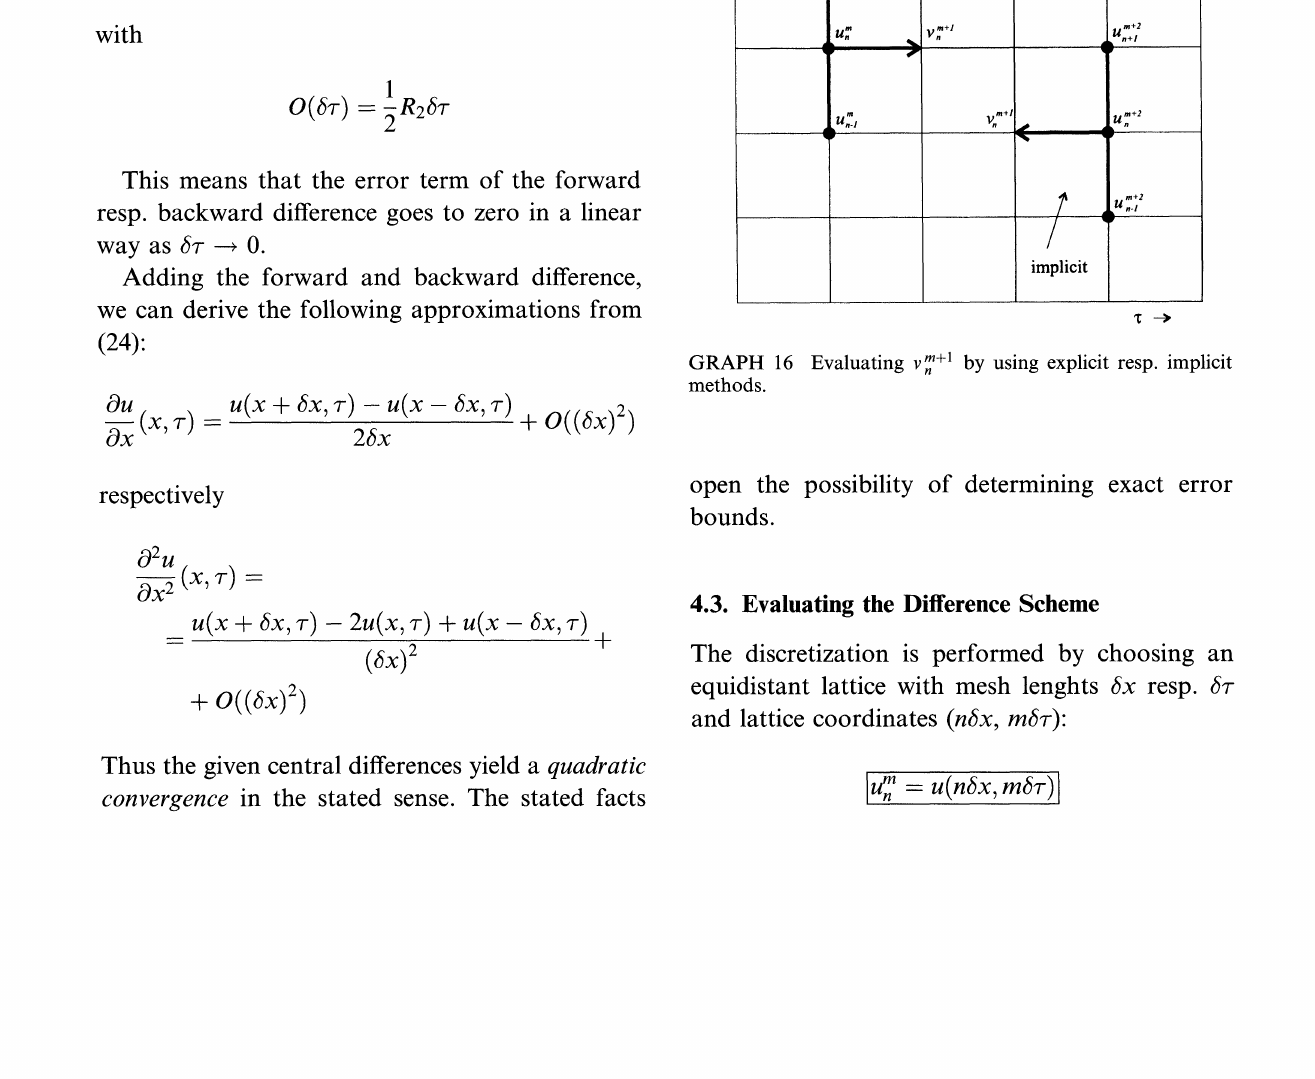
GRAPH 15 Values of u at a fixed